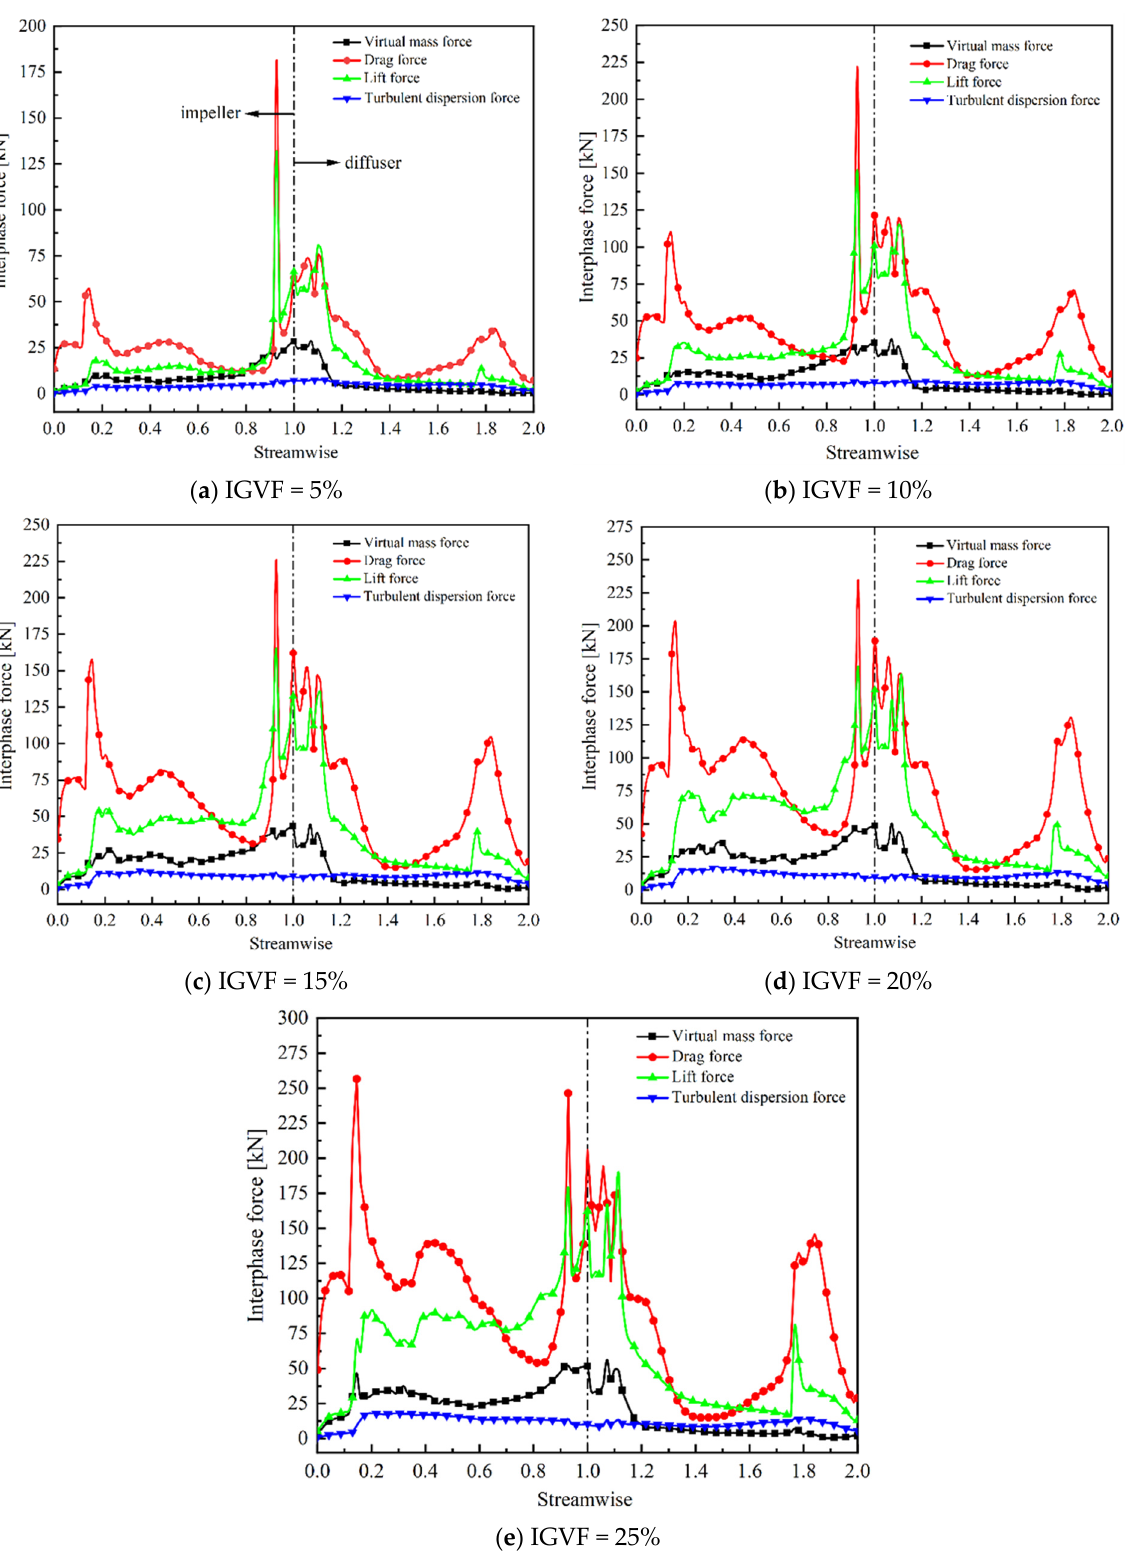
Figure 10. Analysis of interphase force under different IGVF conditions. Contour plots of turbulent kinetic energy distribution in the impeller and diffuser passage under different IGVF conditions are shown in Figure 11. The turbulent kinetic energy in the guide-blade passage was significantly greater than that in the impeller